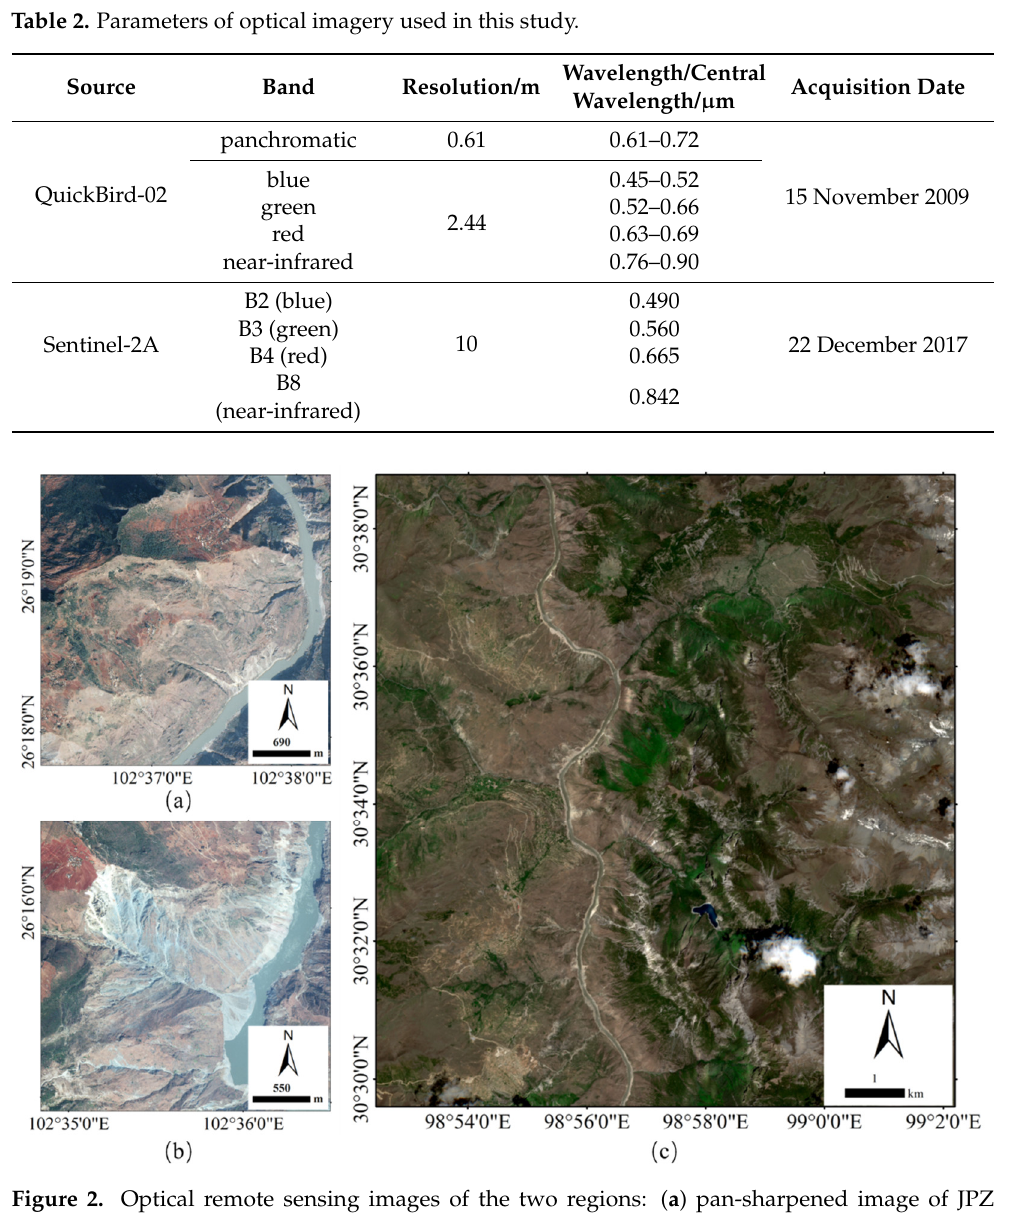
Figure 2. Optical remote sensing images of the two regions: ( a ) pan-sharpened image of JPZ landslides; ( b ) pan-sharpened image of SLT landslides; ( c ) pan-sharpened image over the second region (validation region).